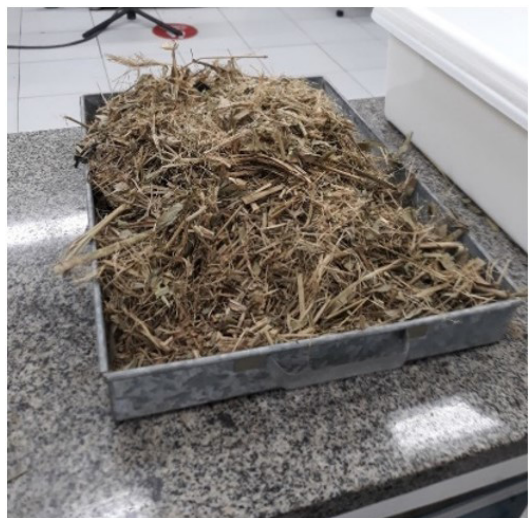
Figure 1. Bamboo fibers after drying in an oven.